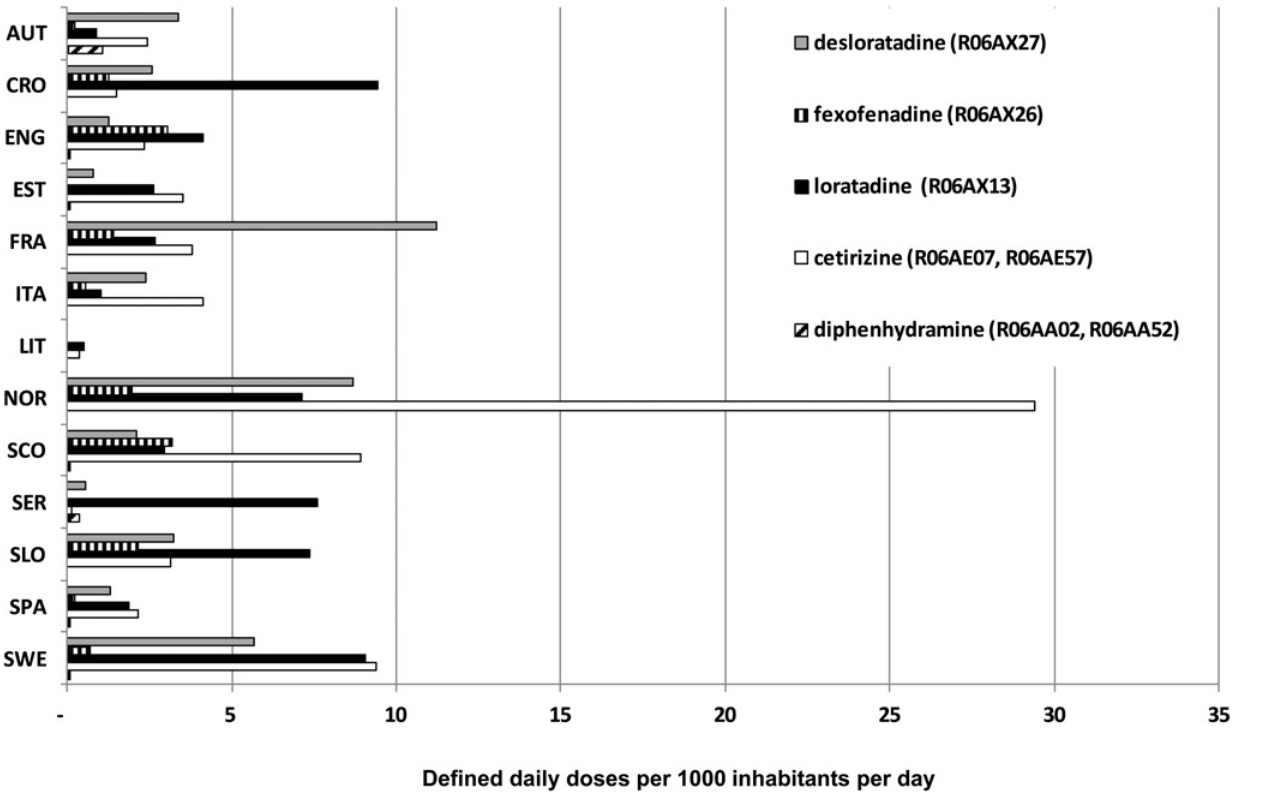
Fig 3. Utilisation of different antihistamines with stronger